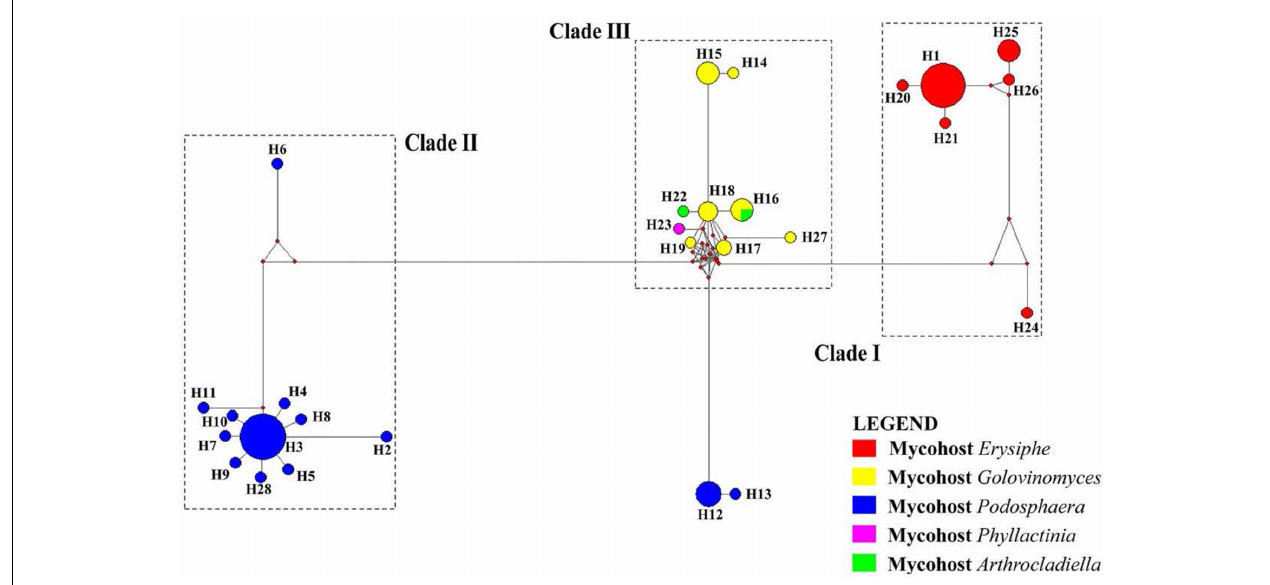
FIGURE 4 | A network of 28 haplotypes of the ITS sequences of 74 Ampelomyces spp. from different mycohost genera. Clades are separated based on their mycohost. Lengths of the branches are proportional to the number of mutation points. The size of each circle is proportional to the frequency of that particular